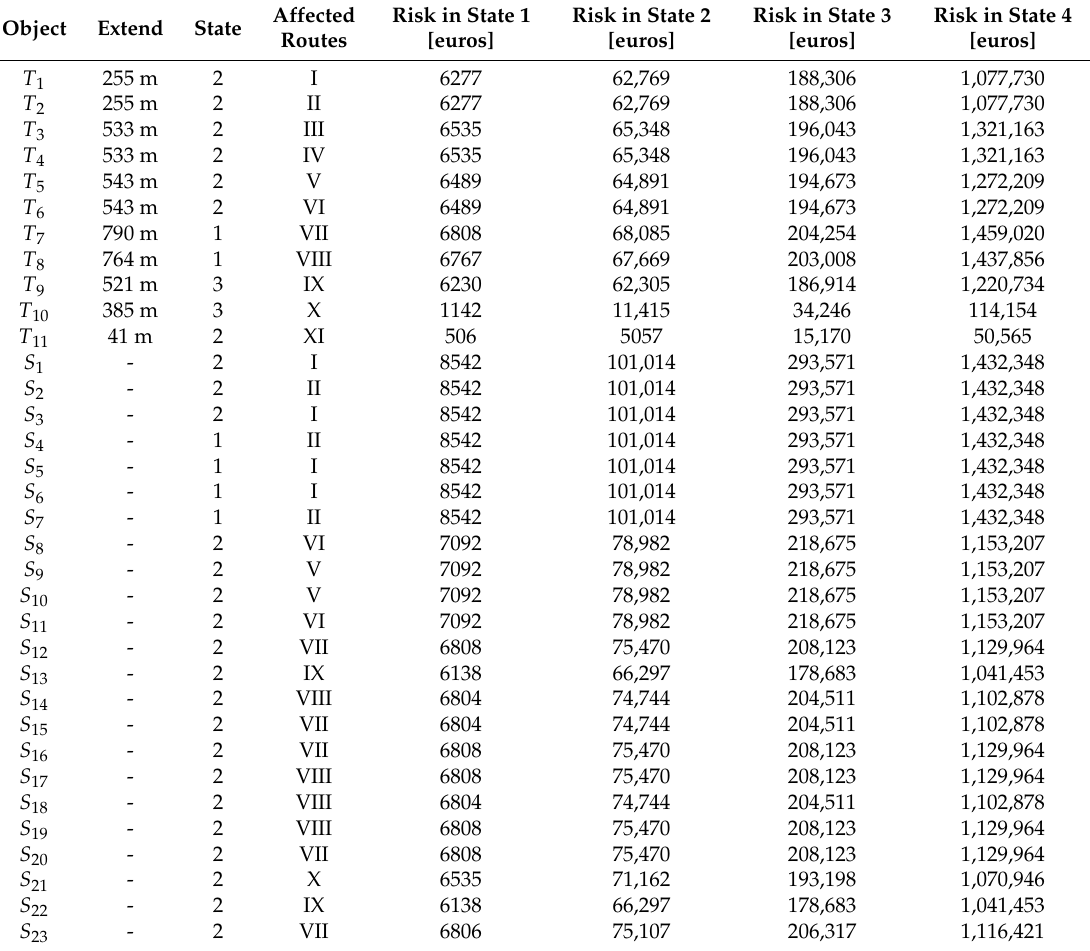
Table A1. Track and switch objects.